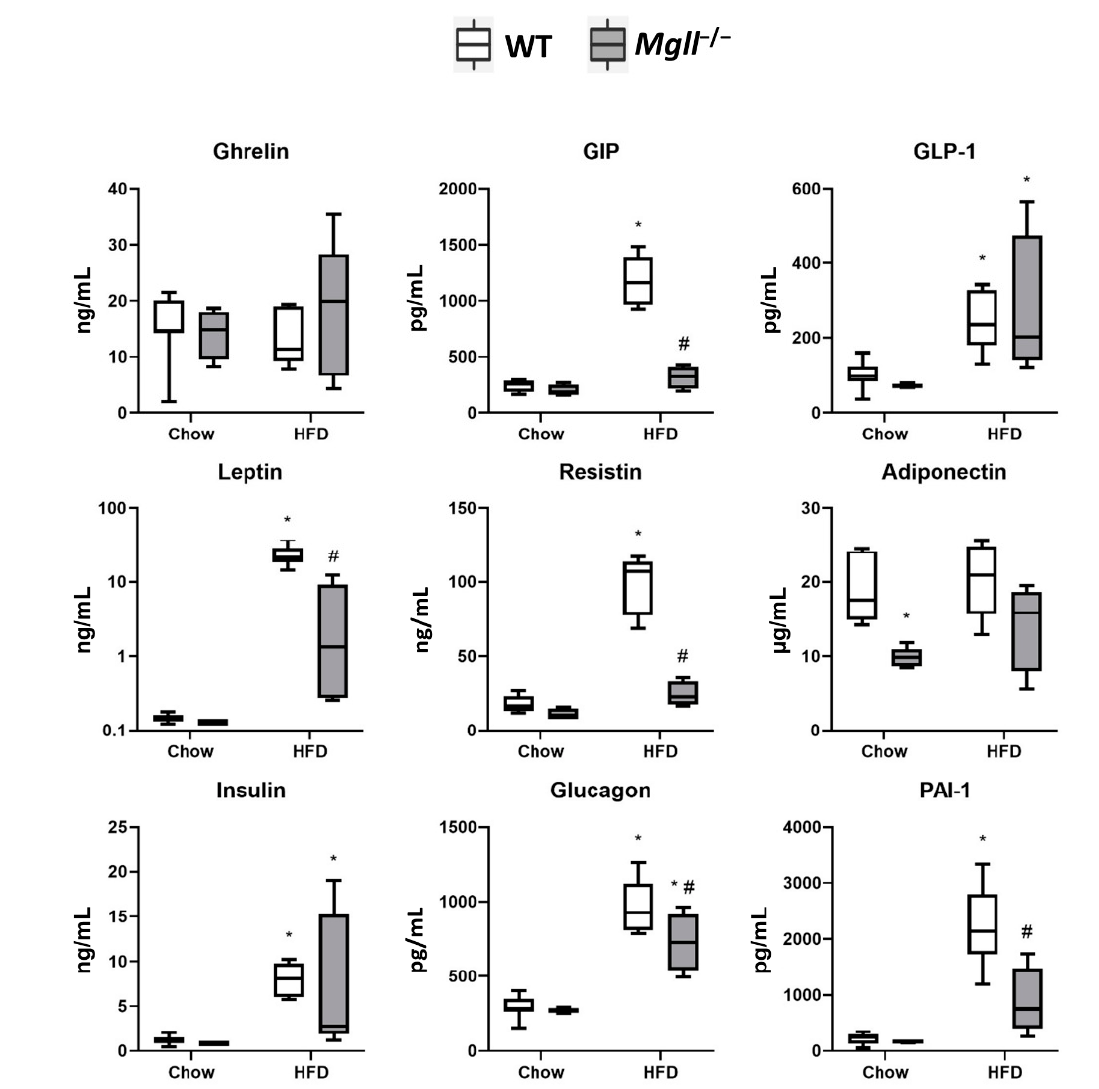
Figure 2. Mgll − / − mice are resistant to HFD-induced changes in plasma peptide levels. Plasma peptide levels were assessed in WT and Mgll − / − on chow or HFD for 22 weeks. Data is presented in box plots extending from the 25th to the 75th percentile with whiskers extending to the 10th and 90th percentile. * p < 0.05 vs. chow control, # p < 0.05 vs. WT control.